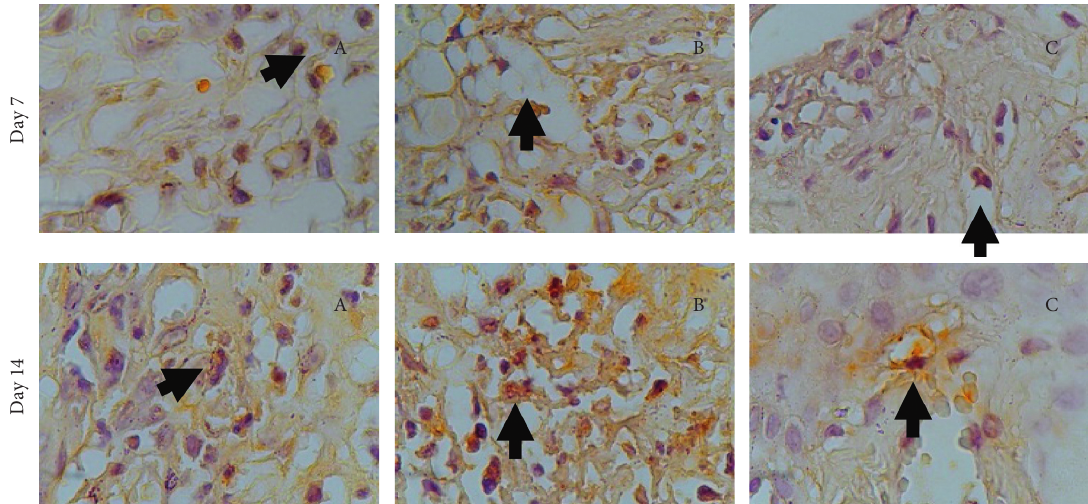
Figure 5: TGF- β 1 (brown) in immunohistochemistry preparation on the 7th and 14th day. (a) Treatment group: combination of SRP+ VCO gel. (b) Positive control group: SRP +metronidazole gel. (c) Negative control group: SRP.